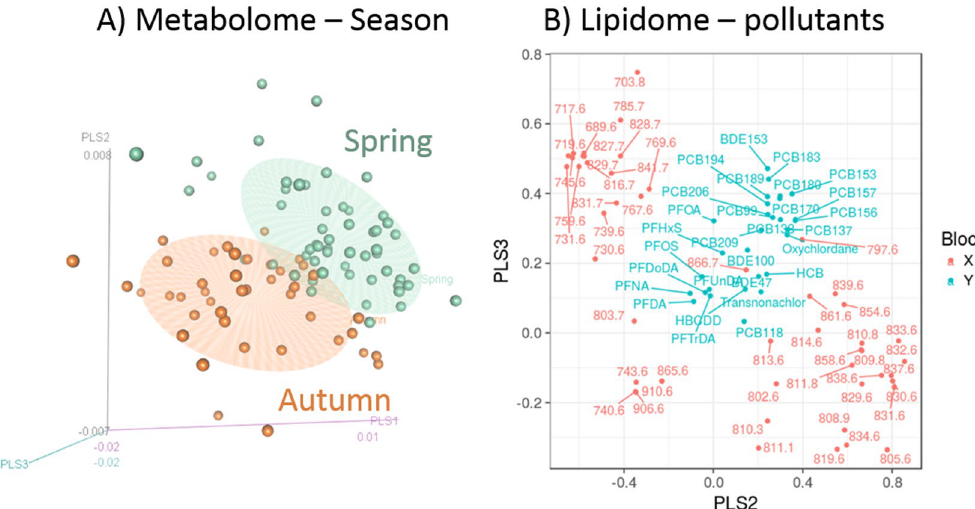
Figure 2. Polar bear metabolome and lipidome. ( A ) Three dimension representation of female polar bears metabolome according to season (n = 111) characterized by low molecular weight metabolites. The three axes are obtained from partial least squares scores. ( B ) Female polar bear lipidome in relation pollutants. The lipidome is characterized by lipid fingerprinting determined in female polar bear plasma (n = 101). The figure represents lipids exact mass (m/z) in pink and pollutants in blue. Bears were sampled at Svalbard, Norway during spring (April: green dots in A) and autumn (September: orange dots in A) 2012 and